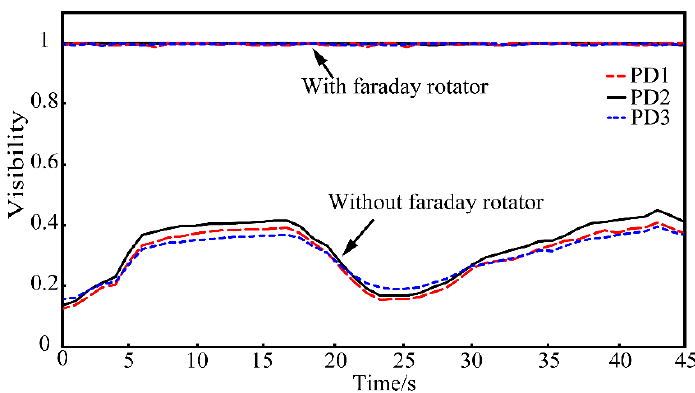
Figure 5. The result of the degradation coefficient caused by the polarization.